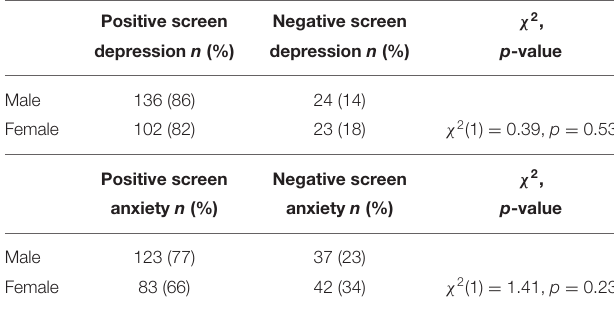
TABLE 3.2 | Sex differences in screening for further assessment of depression and